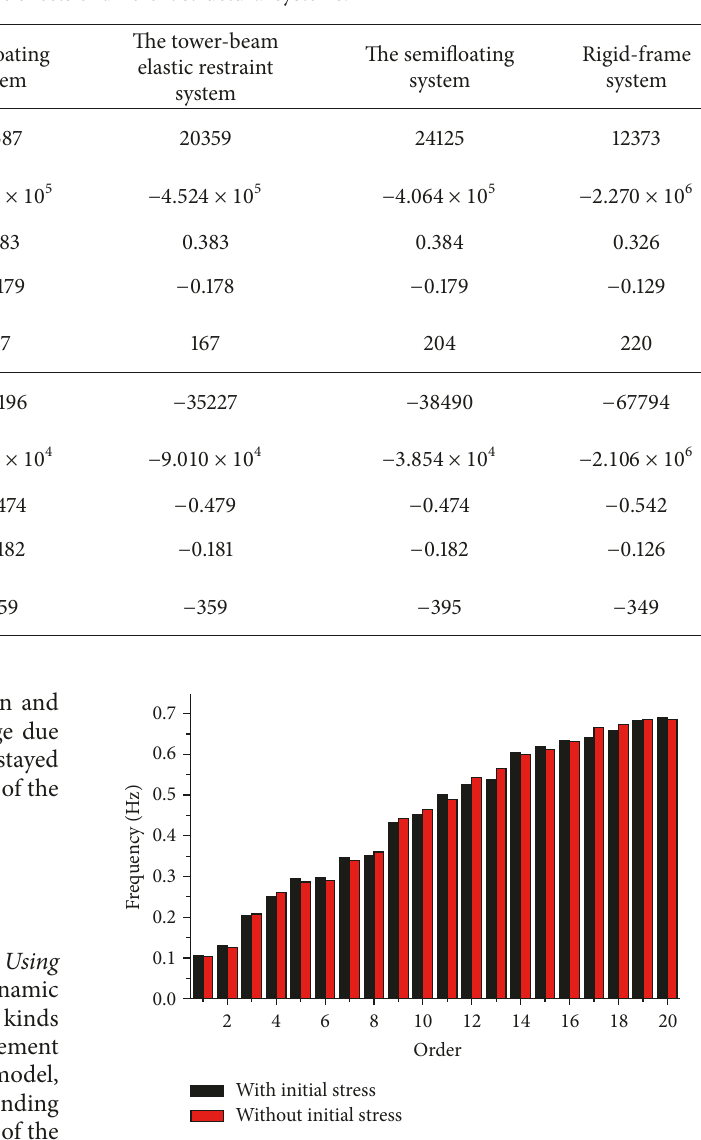
Table 4: Temperature effects of different structural systems.